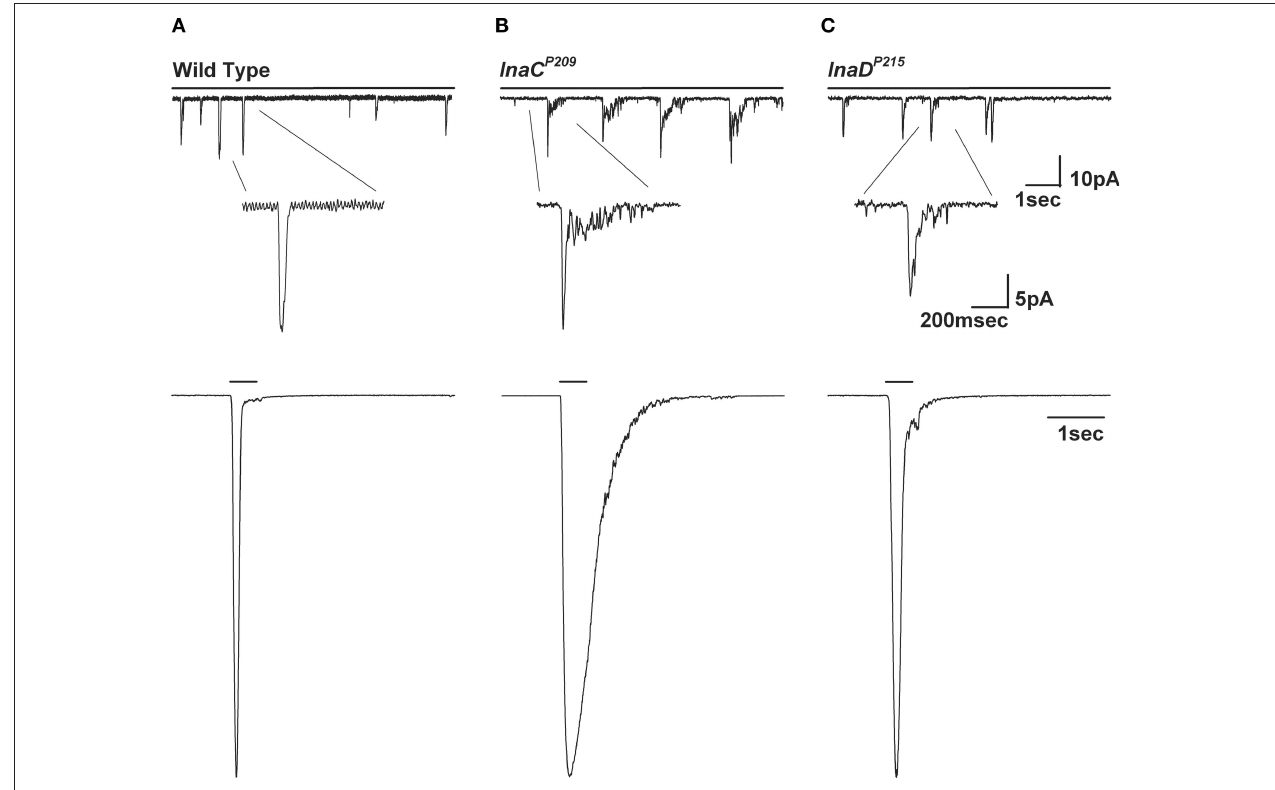
FIGURE 11 | The inaC P209 and inaD P215 mutants reveal slow response termination of the macroscopic response to light and of the single bumps. (A–C) Upper panels: Whole-cell voltage clamp quantum bump responses to continues dim light in wild-type, inaC P209 and inaD P215 mutant fl ies. A slow termination of the bumps is observed in inaC P209 and inaD P215 mutant fl ies.